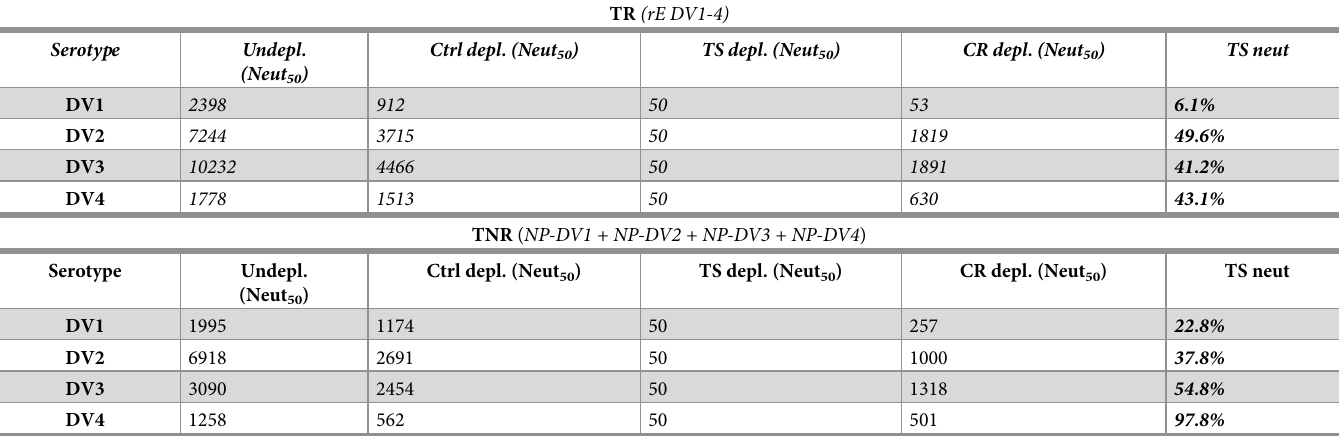
Table 2. Particulated rE induced a balanced serotype specific tetravalent neutralizing antibody response in mice.